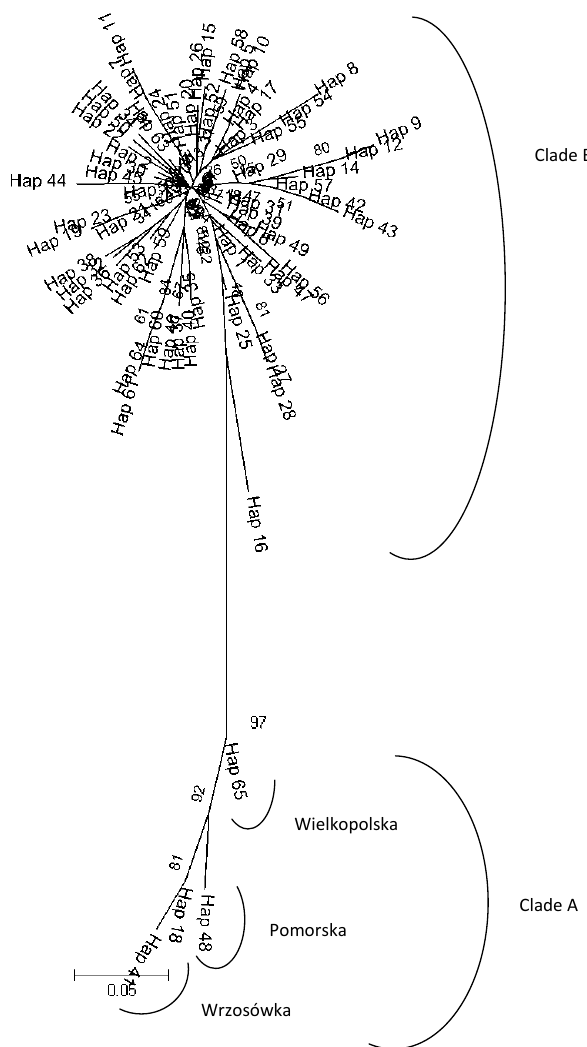
Figure 1. Unrooted neighbour-joining haplotype tree constructed from Kimura two-parameter distance of the 65 haplotypes of the Polish sheep breeds studied; bootstraps of 1000 replicates were used to test the robustness of the